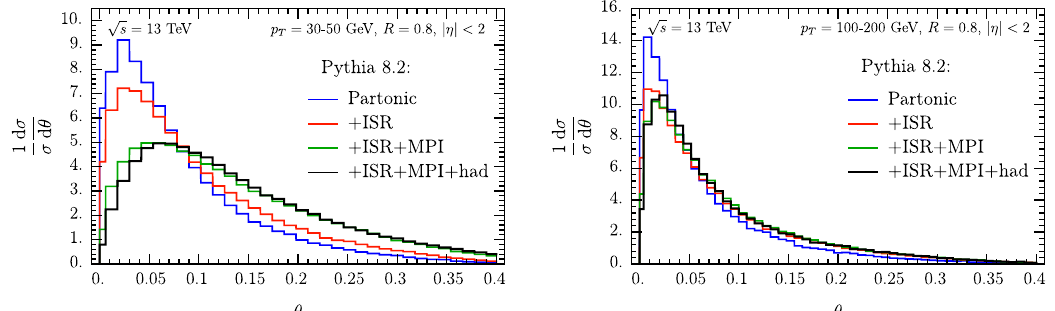
Figure 7 . Numerical results for the angle between the WTA and the standard jet axis at NLL accuracy (orange curve and band) for four jet transverse momentum intervals as indicated in the (cid:12)gure. We choose proton-proton collisions at p s = 13 TeV where jets are identi(cid:12)ed with the anti-k T algorithm with R = 0 : 8 at central rapidity with results at parton level (dotted blue) and when ISR, MPI and hadronization are included (solid blue).